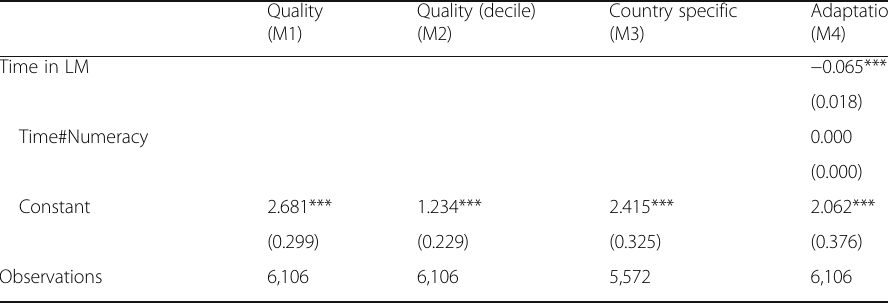
Abbreviations PIAAC: Programme for the International Assessment of Adult Competencies